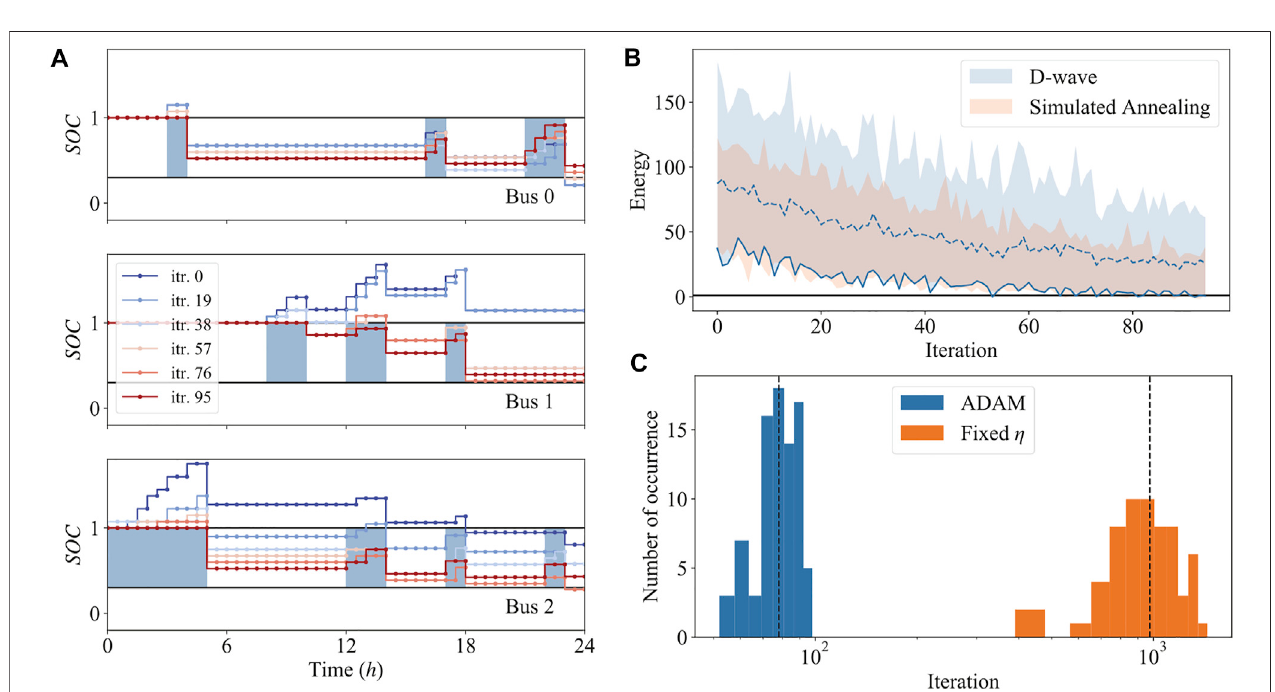
FIGURE 3 | (A) State-of-charge SOC at different iterations calculated based on the lowest energy sample from D-Wave annealer with the Hubbard-Stratonovich (HS) transformation method. The two solid black lines indicate respectively SOC (cid:2) 0.3 and SOC (cid:2) 1, between which the constraints are satis fi ed. Blue shaded areas represent the time intervals during which the bus is available for charging. (B) Distribution of the sampled energy of the dual Hamiltonian at each iteration. The blue and orange shaded areas represent sampling results from the D-Wave sampler and simulated annealing, respectively. The blue solid (respectively, dashed) line indicates the lowest value (respectively, the median) of the samples. The black solid line marks the lowest energy of the original Hamiltonian (without HS transformation) sampled by simulated annealing with an extended period of time. (C) Histogram of number of iterations till convergence (all constraints are satis fi ed) with two different strategies of updating the multipliers μ : ADAM represents adaptive gradient and constant learning rate η (cid:2) 0.1. All plots are obtained for the same problem with parameters N bus (cid:2) 3, N pile (cid:2) 2, L time (cid:2) 48.